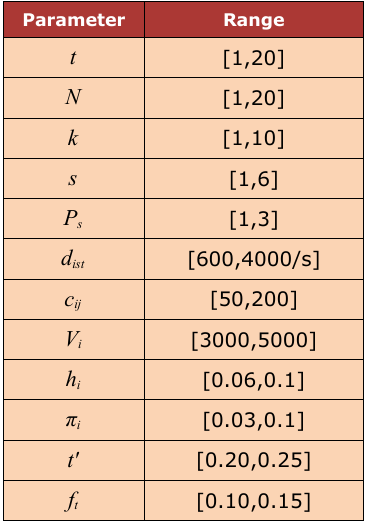
Table 2. Range for random generation of parameters